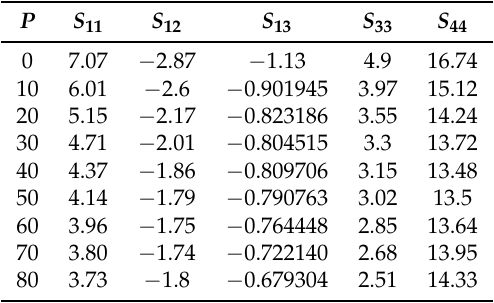
Table 3. The elastic compliances S ij (in × 10 − 3 GPa − 1 ) of Ti 3 Al under pressure up to 80